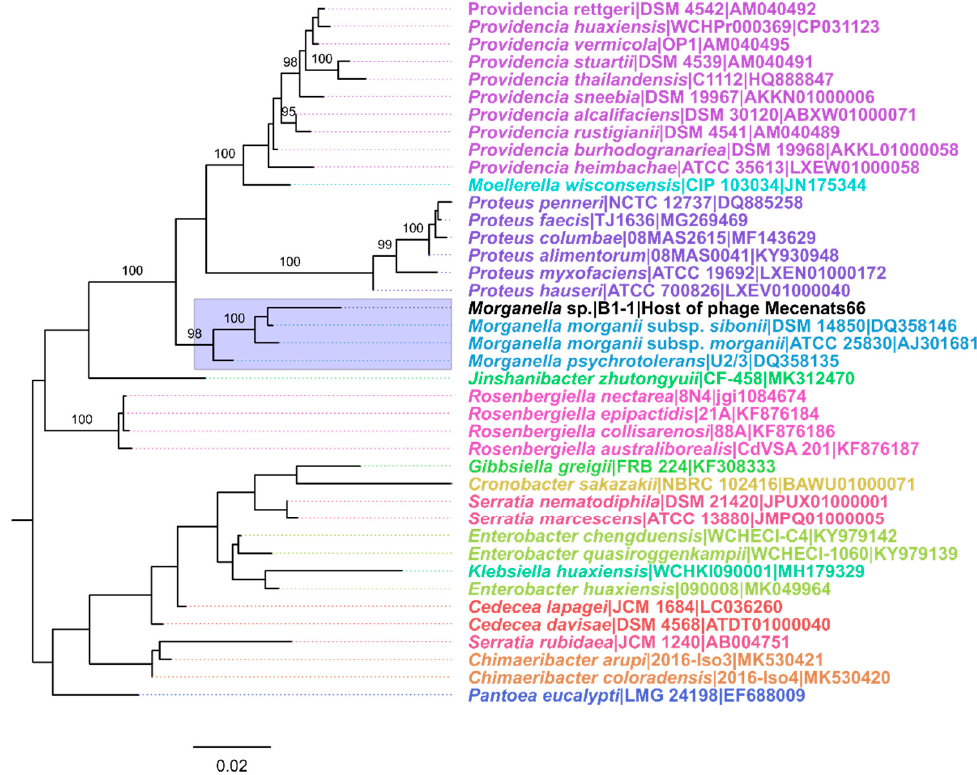
Figure 1. The maximum-likelihood tree of the partial 16S rRNA gene sequences of the bacterial isolate B1-1 and closely-related bacterial species. The analysis involved 40 nucleotide sequences (16S rRNA gene sequences of isolate B1-1 and 39 other most closely related bacterial species identified). The tip labels correspond to the taxa and are in the format of “Species|Strain|Accession” and are colored based on the genus of the bacteria from which the sequence was derived. Isolate B1-1 is indicated by the black font, and the clade corresponding to the 16S rRNA sequences of bacterial genus Morganella representatives is highlighted in light blue. Input alignment had 1465 columns, 284 distinct patterns, 183 parsimony-informative, 41 singleton sites, and 1241 constant sites. The tree was built using TN + F + I + G4 as the best-fit substitution model. Near zero-length branches were collapsed into polytomies. The tree shown is midpoint rooted. The percentage of replicate trees in which the associated sequences clustered together in the ultrafast bootstrap (UFBoot; 1000 replicates) is shown next to the branches for branches with UFBoot support higher or equal to 95%. The tree is drawn to scale, branch lengths represent the number of nucleotide substitutions per site.